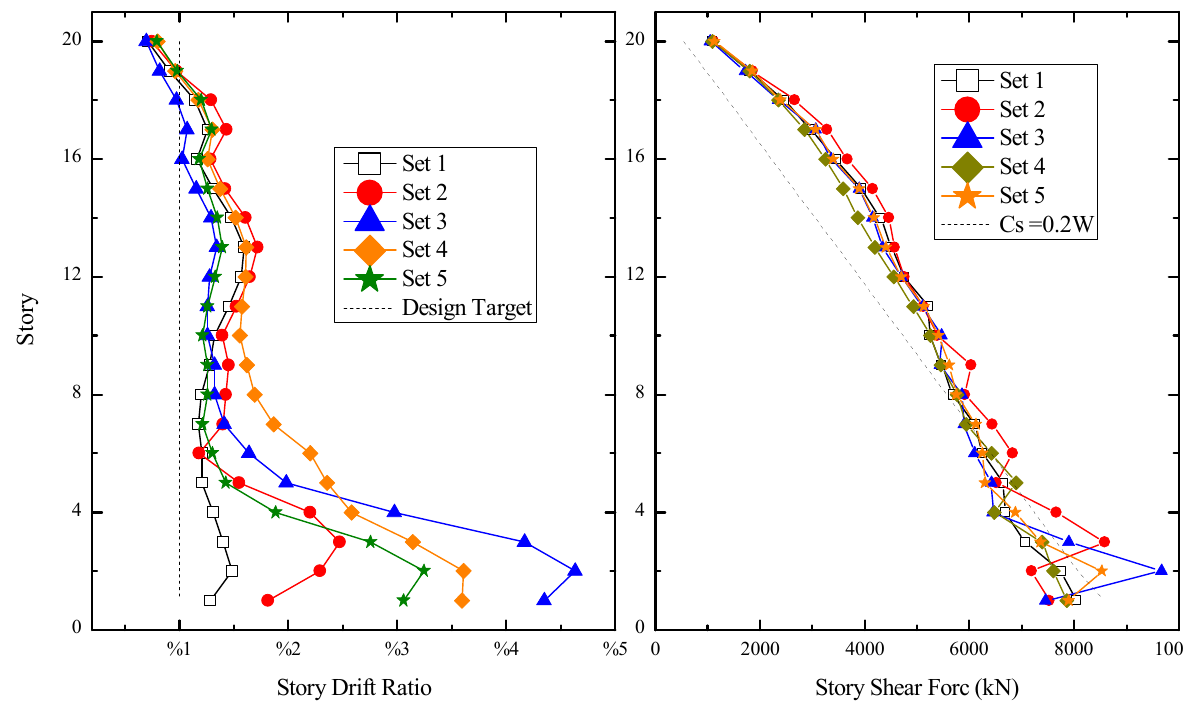
Figure 16. Maximum story drift ratio and shear force under multi-hazard scenarios.